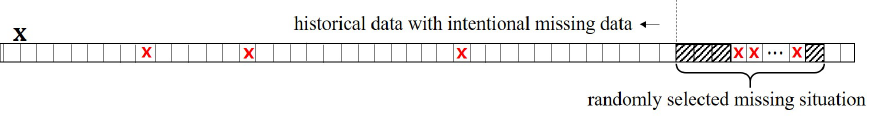
Figure 11. Setting for performance evaluation according to the missing